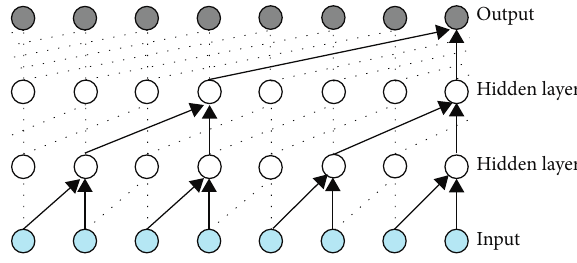
Figure 5: Dilated causal convolution